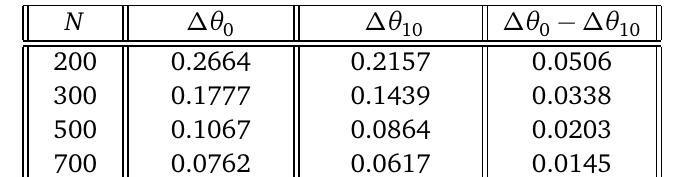
Table 4: Numerical values of the rapidity discretisation intervals ∆ θ , for a given number of rapidity points N in the range of rapidities used in this investigation θ P r´ 17,17 s .